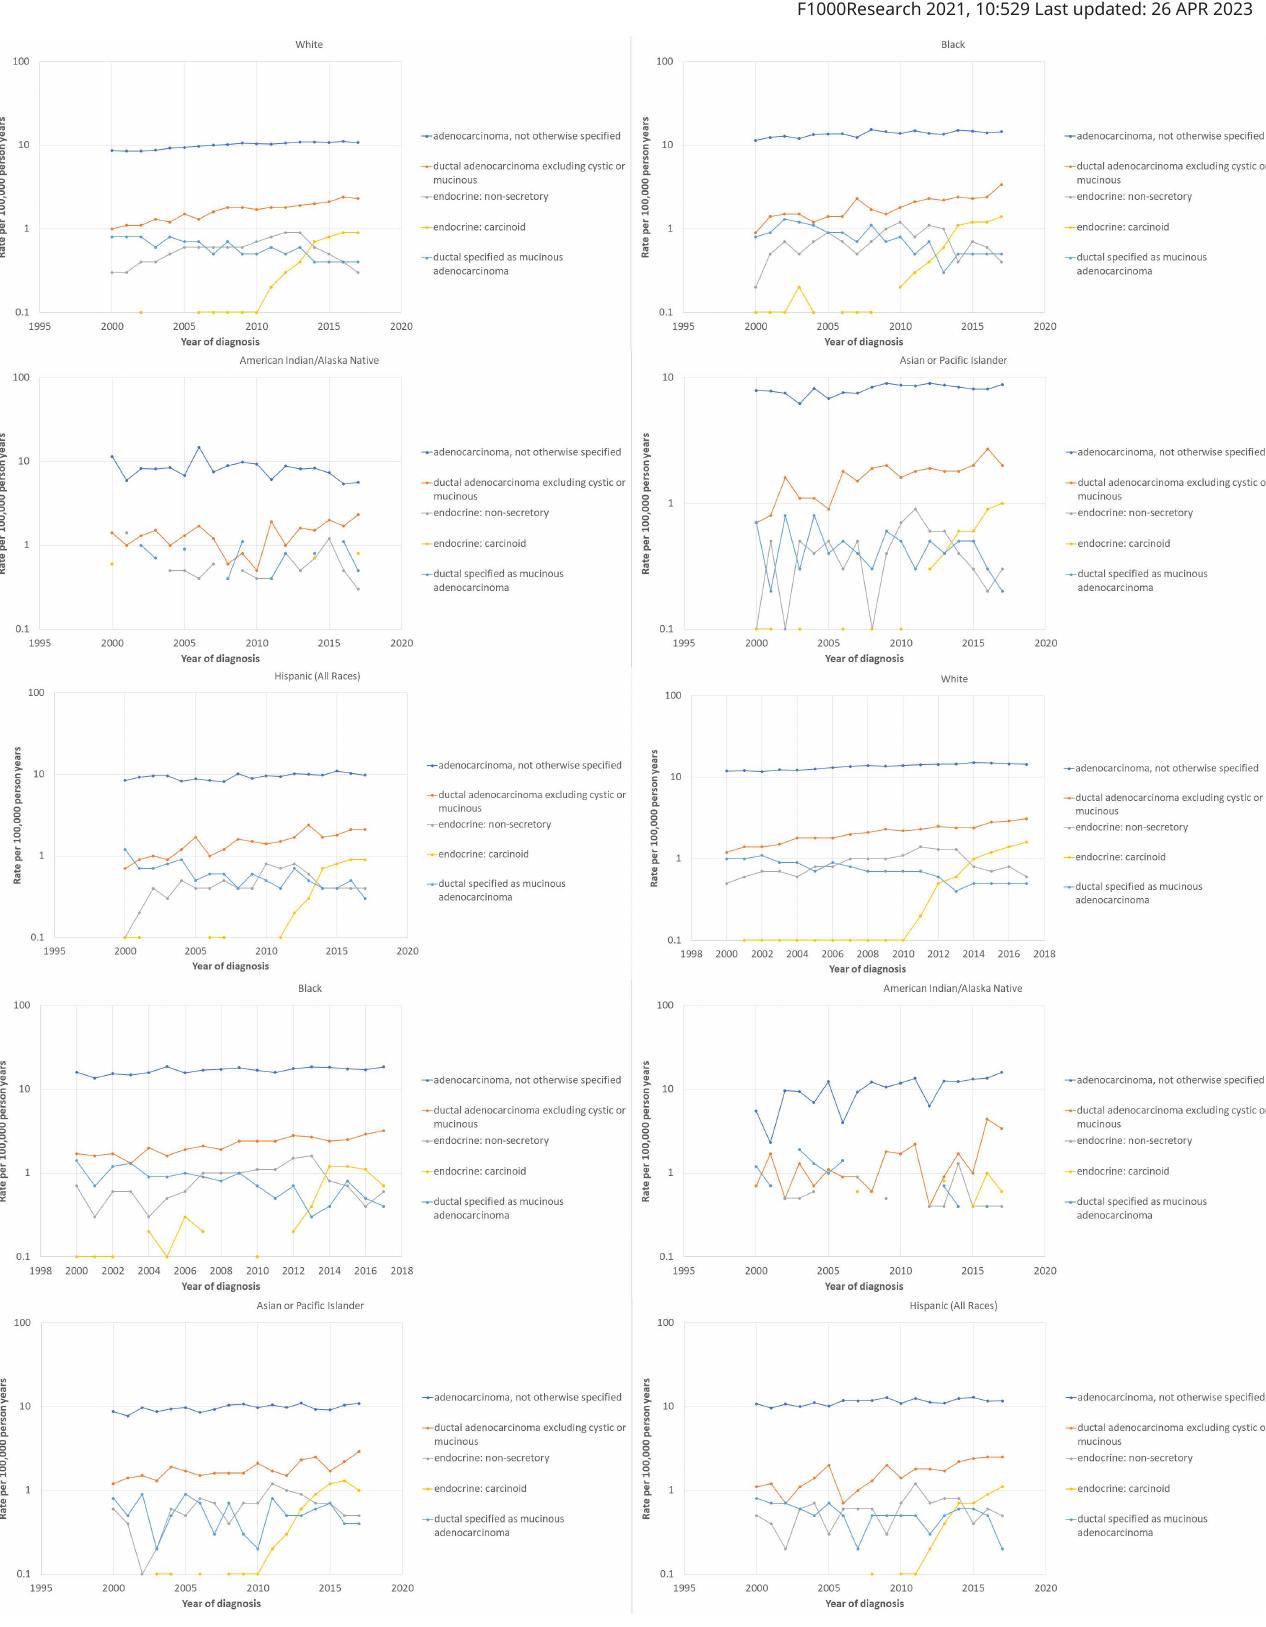
Figure 3. Pancreatic cancer incidence trends by age groups, gender and histological type based on SEER 18 (2000–2017). a: Males, b: